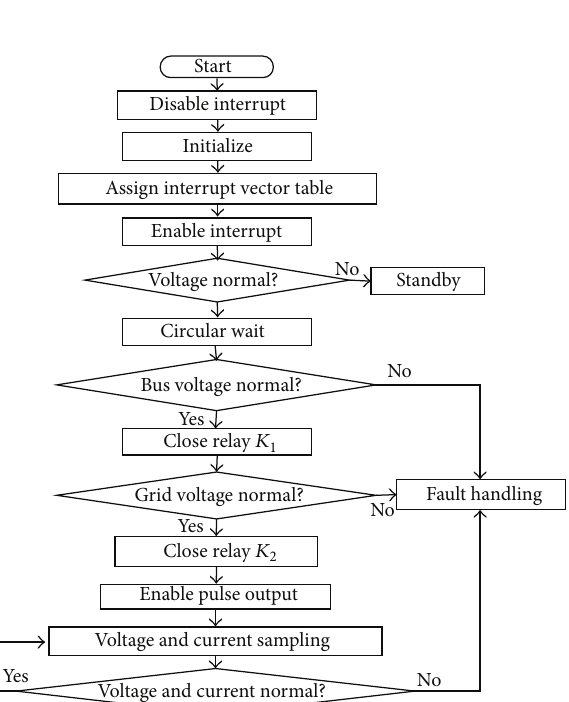
Figure 4: The main program flow chart.